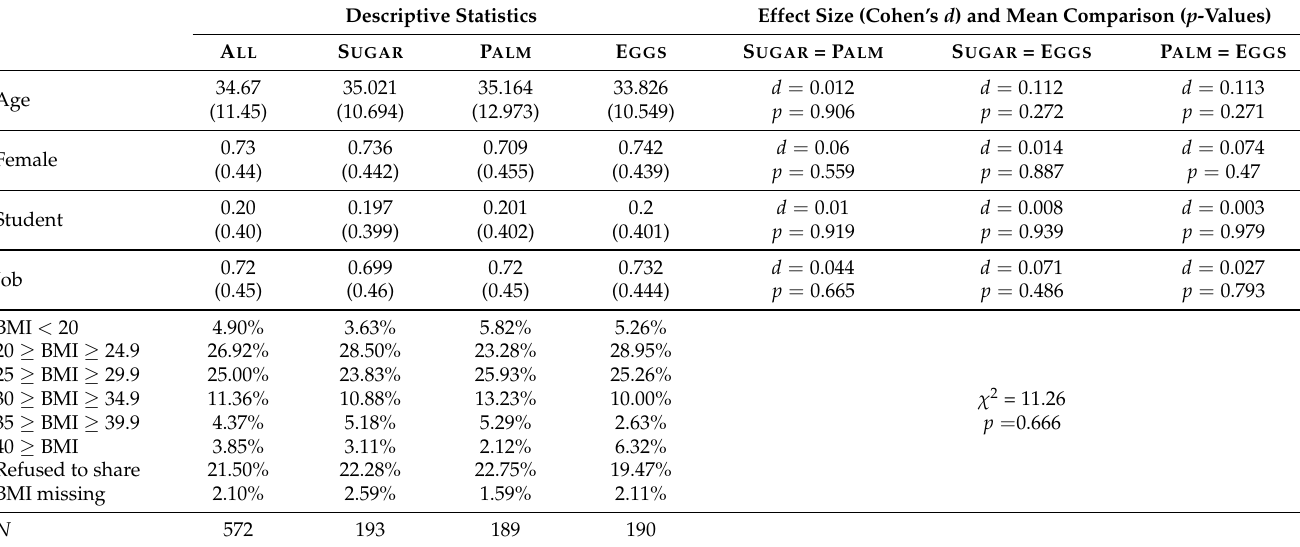
Table 3. Descriptive statistics for